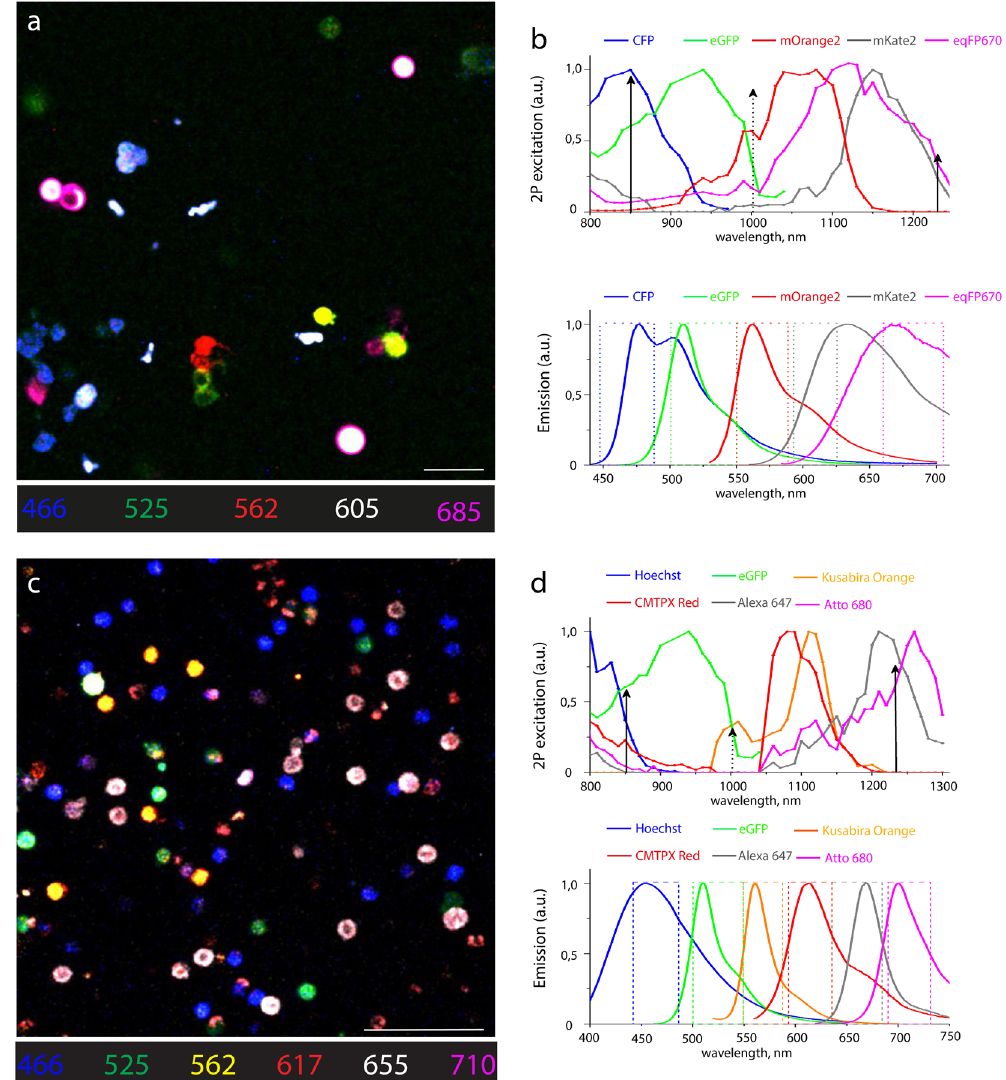
Figure 2. In vitro spectrally multiplexed imaging of five fluorescent proteins in HEK cells and six chromophores in murine splenocytes. ( a ) Raw fluorescence image of a mixture of HEK cells singly expressing one of five FPs: CFP, eGFP, mOrange2, mKate2, and eqFP670. ( b ) Two-photon excitation and emission spectra of CFP, eGFP, mOrange2, mKate2, and eqFP670. Two-photon spectra of mOrange2, mKate2, and eqFP670 were recorded in this work (Methods). Arrows indicate effective excitation wavelengths and rectangles indicate the filter bandwidth of the five detection channels (a.u., arbitrary units). ( c ) Raw image of a mixture of murine splenocytes each labelled with one of six fluorophores: Hoechst, eGFP, Kusabira Orange, CMTPX Red, Alexa 647, and Atto 680. ( d ) Two-photon excitation and emission spectra of Hoechst, eGFP, Kusabira Orange, CMTPX Red, Alexa 647, and Atto 680. 2P spectra of Hoechst, Kusabira Orange, CMTPX Red, Alexa 647, and Atto 680 were recorded (Methods). Arrows indicate optimal excitation wavelengths and rectangles indicate the filter bandwidth of the six detection channels (a.u., arbitrary units). Scale bars, 50 μ